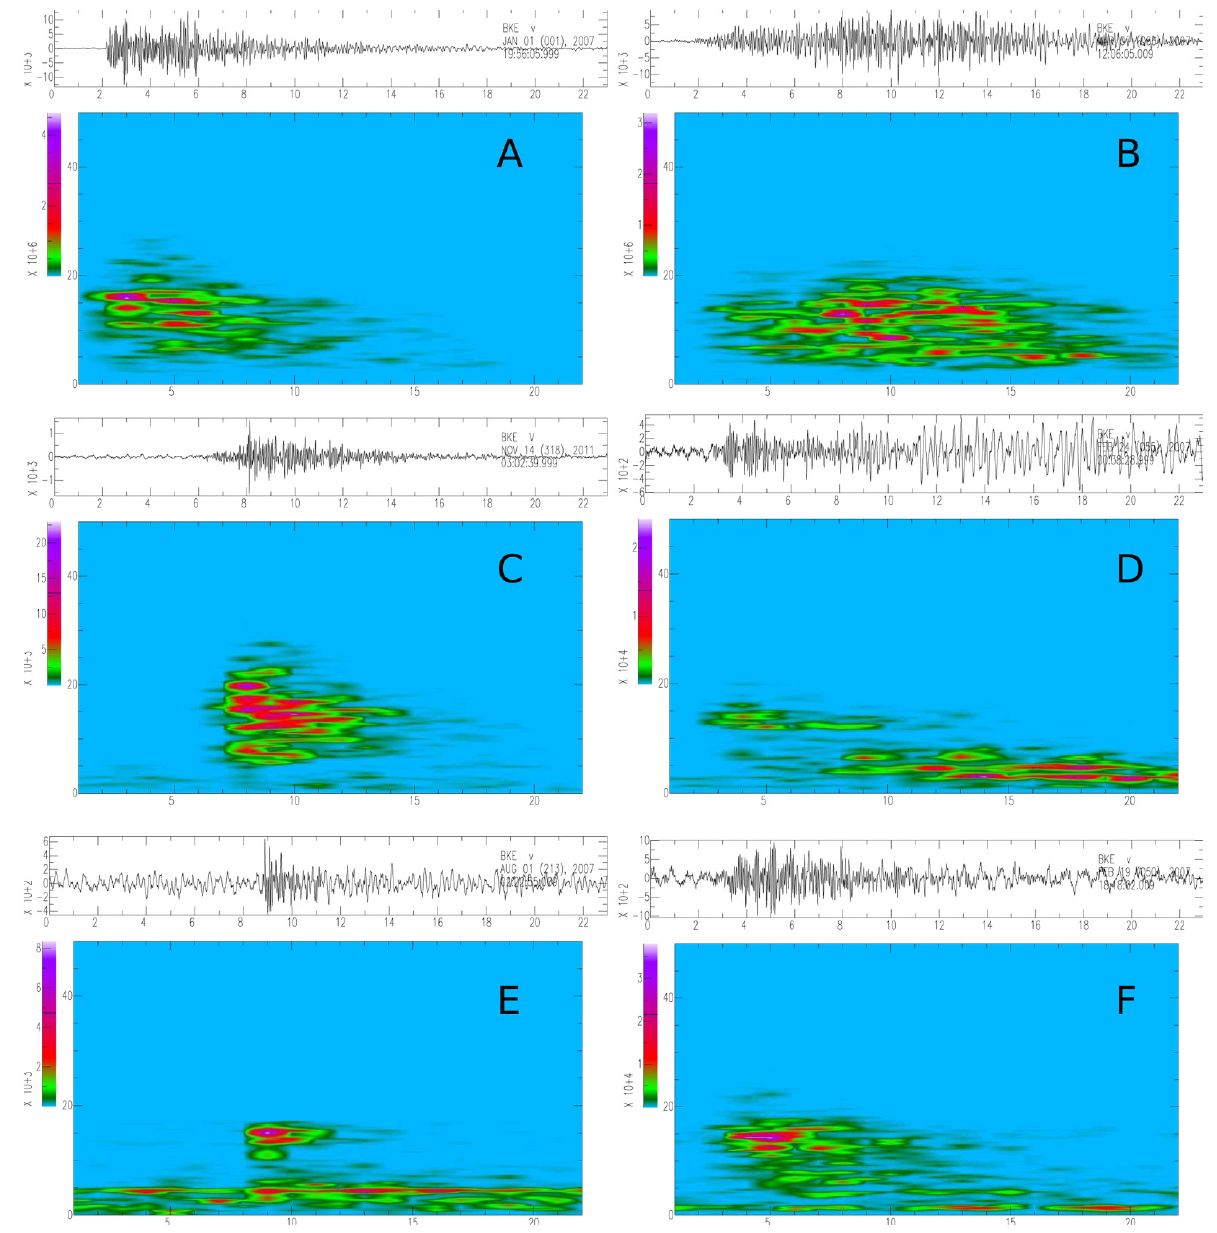
Figure 2. The 22s time windows show the seismograms (top panels) and the corresponding spectrograms (bottom panels) of the signals rep- resentative of the four classes of events: an earthquake (A), a landslide (B), a quarry blast (C), an undersea explosion (D), a not classified event (E) and a thunder signal (F), both belonging to the class